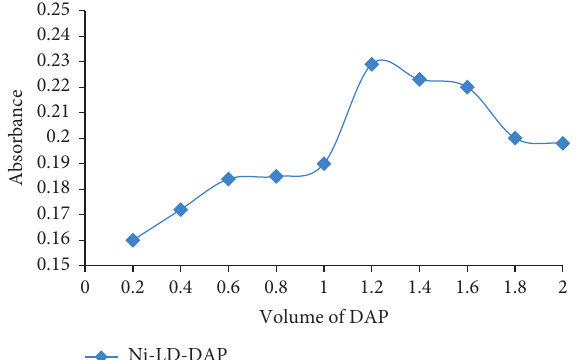
Figure 4: Effect of DAP volume on the maximum absorbance signal of LD.